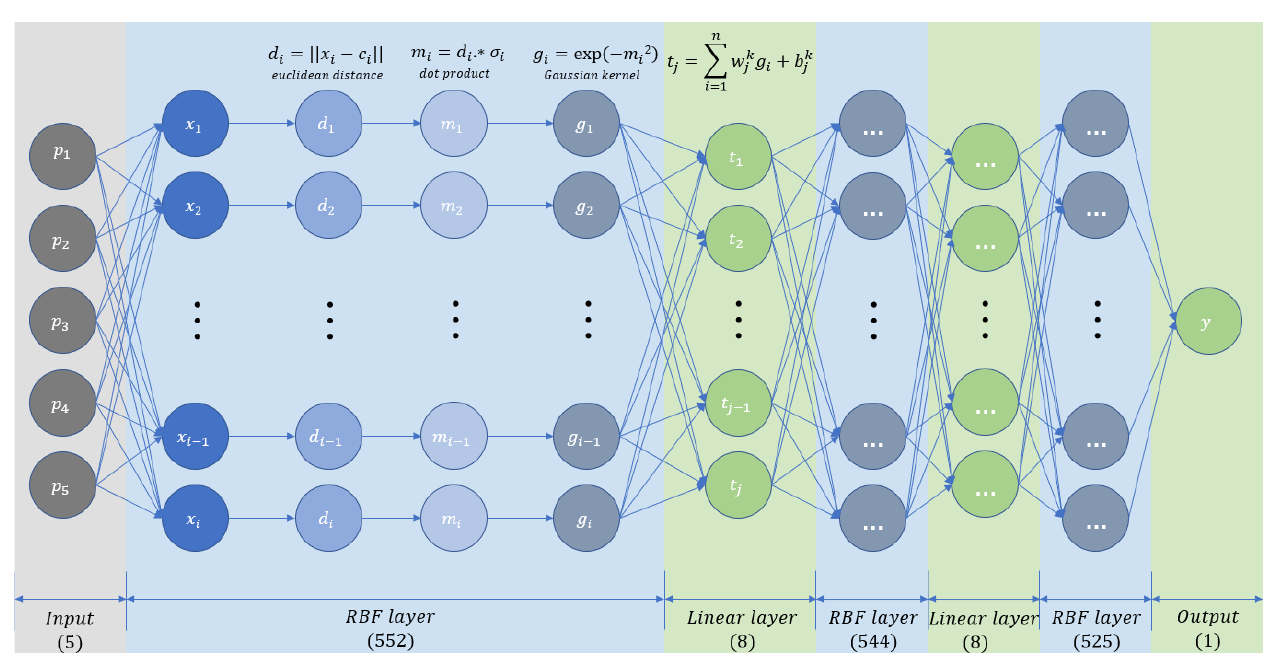
Figure 4. Our structure of the multilayer RBF network in this paper.